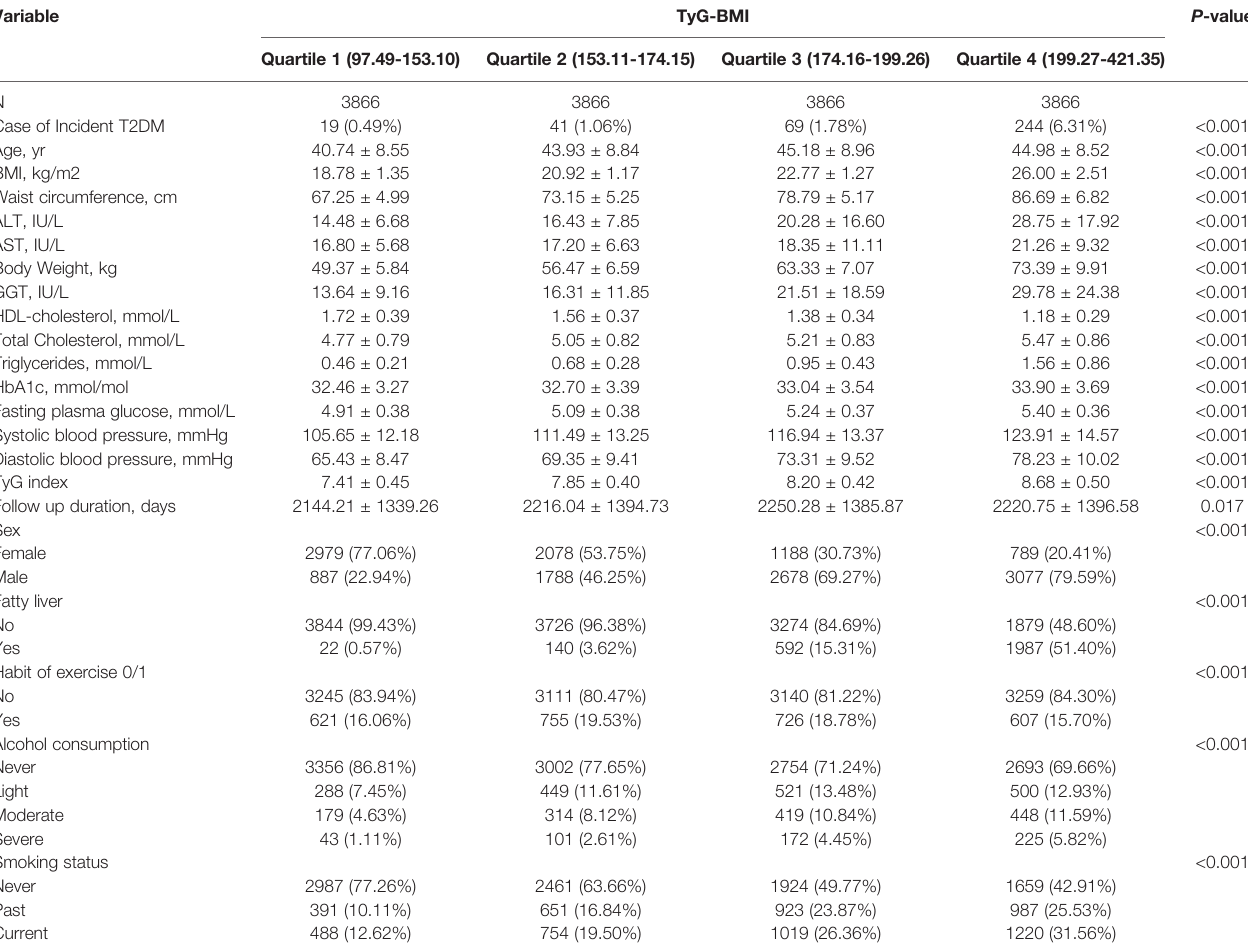
TABLE 1 | Baseline variables according to the quartile of TyG-BMI.